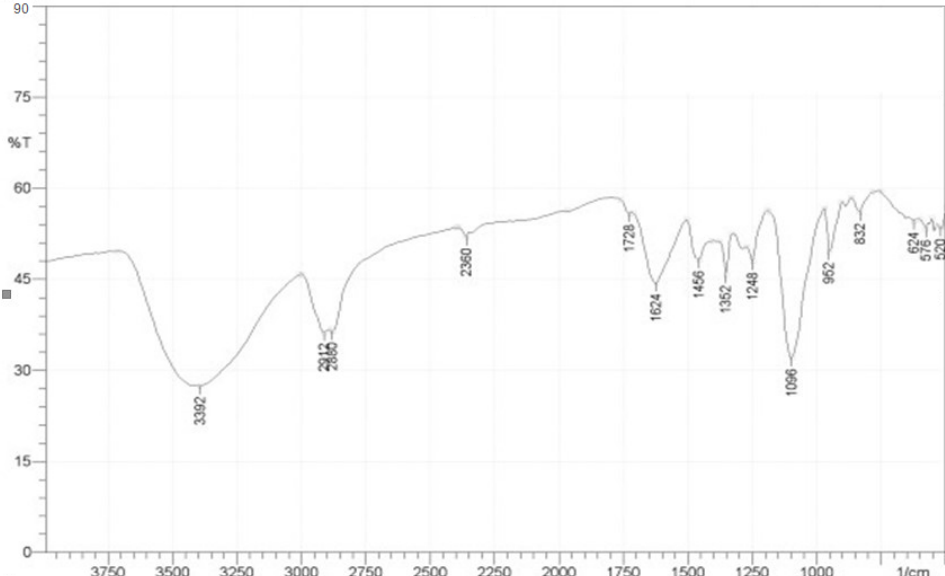
Figure 5. FTIR spectrum of iron oxide nanoparticles synthesis by grape seed extract under (GS water extract mixing with ferrous chloride (GS-IONPs) at pH 3.8 and ratio 2:1).